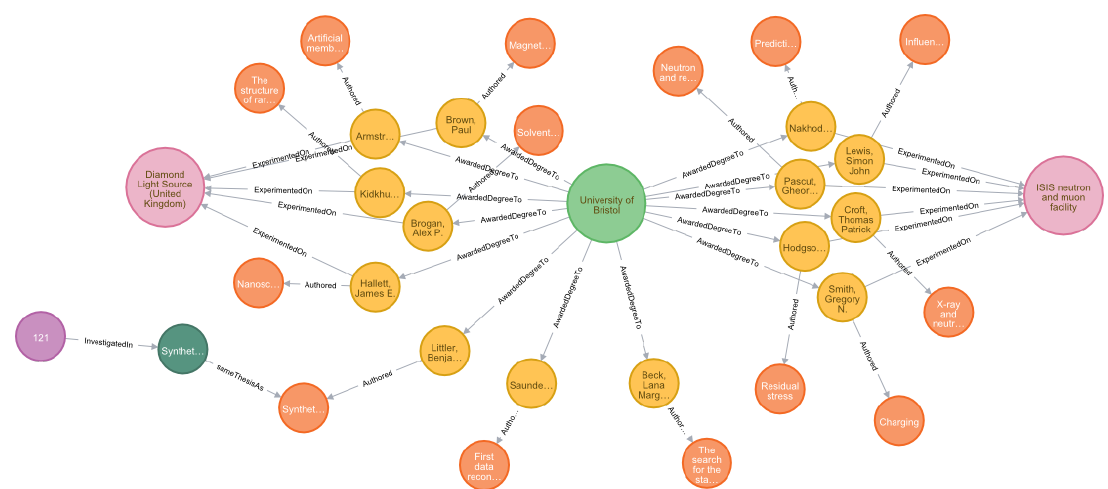
Figure 3. A subgraph demonstrating the ChemSpider integration. It shows the University of Bristol (central node), PhD students where some of them experimented on two research facilities (larger nodes on the left and on the right) and the thesis nodes connected to students with the “Authored” relationship. The nodes in the bottom left of the diagram indicate a thesis from ChemSpider with “same” relationship to the EThOS thesis and with the chemical compound node on the far left.